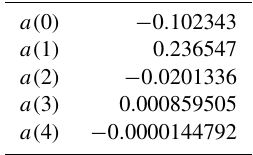
Table 4. Coefficients a(i) , i = 0 , 4 used in Eq. (13a) to compute